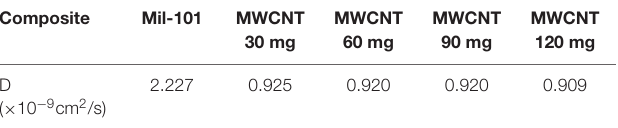
TABLE 6 | Water adsorption diffusion coefficient of carbon nanotube mil-101 (Cr) composite and mil-101 (Cr) material.